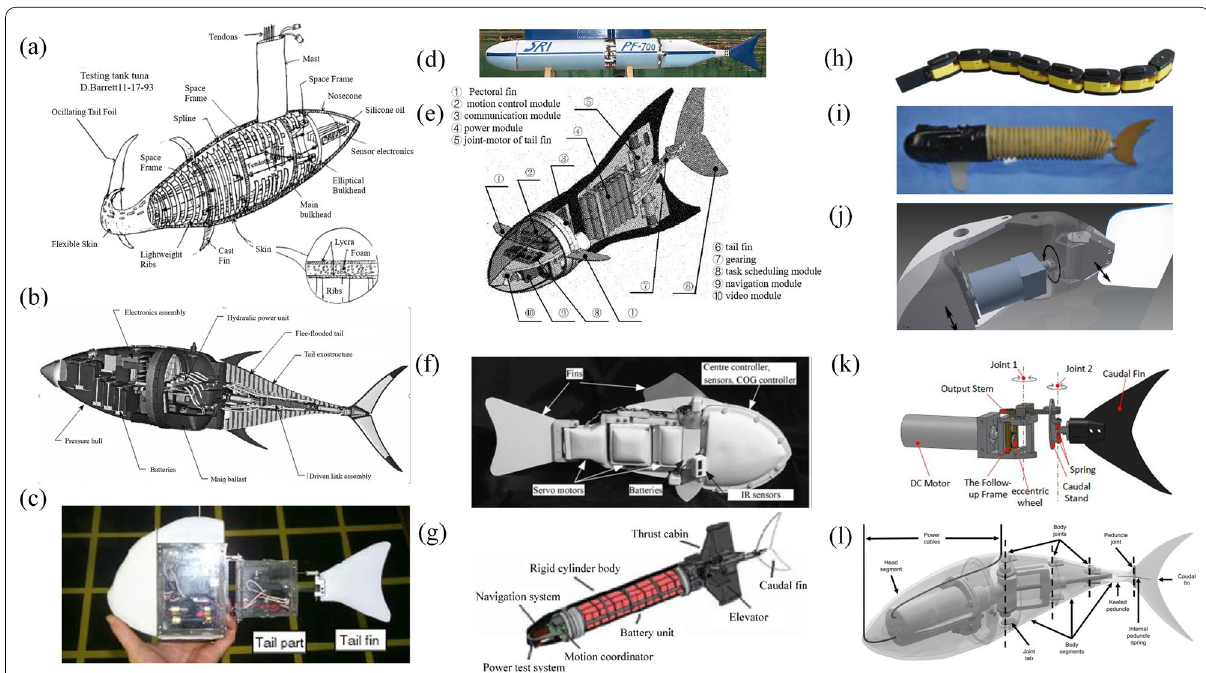
Figure 7 The rigid robotic fish motioned in Table 4: ( a ) Robotuna made by MIT [193]; ( b ) VCUUV made by Draper Laboratory [194]; ( c ) PF-300 and ( d ) PF-700 are designed by NMRI (The Japanese National Maritime Research Institute); ( e ) SPC-II made by Beihang University [195]; ( f ) G9 made by Essex University [196]; ( g ) SPC-III made by Beihang University [197]; ( h ) AmphiBot III designed by IMT Atlantique [30]; ( i ) CAS robotic fish designed by Chinese Academy of Sciences [198]; ( j ) iSplash -II designed by Essex University [199]; ( k ) PKU robotic fish designed by Peking University [200]; ( l ) Tunabot designed by Harvard University